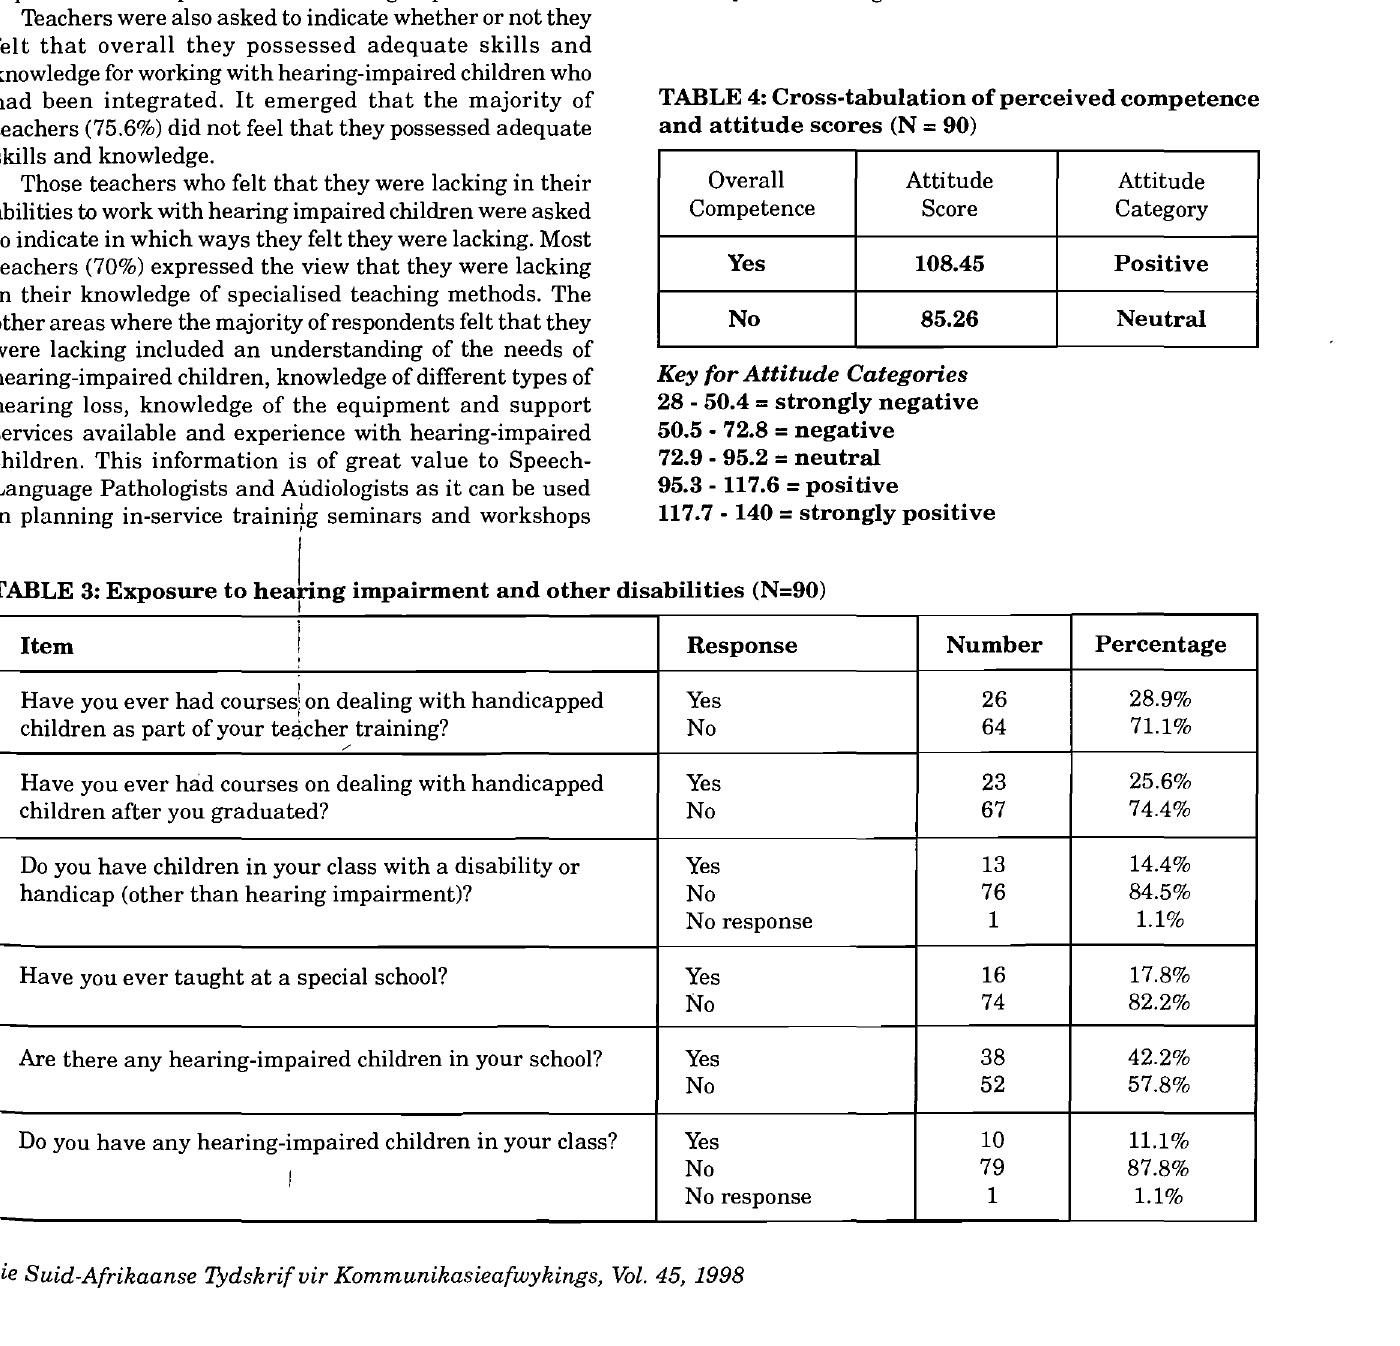
TABLE 4: Cross-tabulation of perceived competence